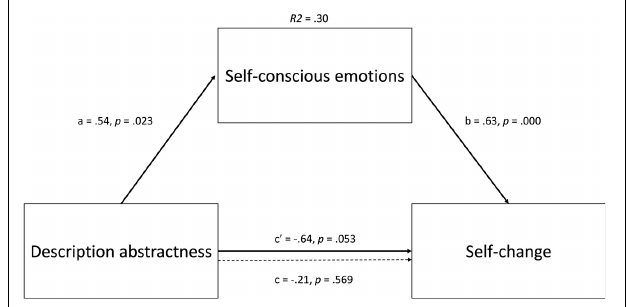
FIGURE 1 | Direct and indirect effects in model 4 when spatial distance is entered as covariate. Dotted line denotes the effect of description abstractness on self-change when self-conscious emotion is not included as a mediator.